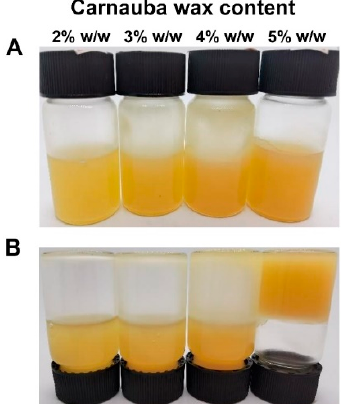
Figure 2. ( A ) Photographs of rice bran oil samples at different contents of carnauba wax (2–5% w/w); ( B ) Photographs of inverted rice bran oil samples at different contents of carnauba wax (2–5% w/w) after inverting the vials for 1 h.